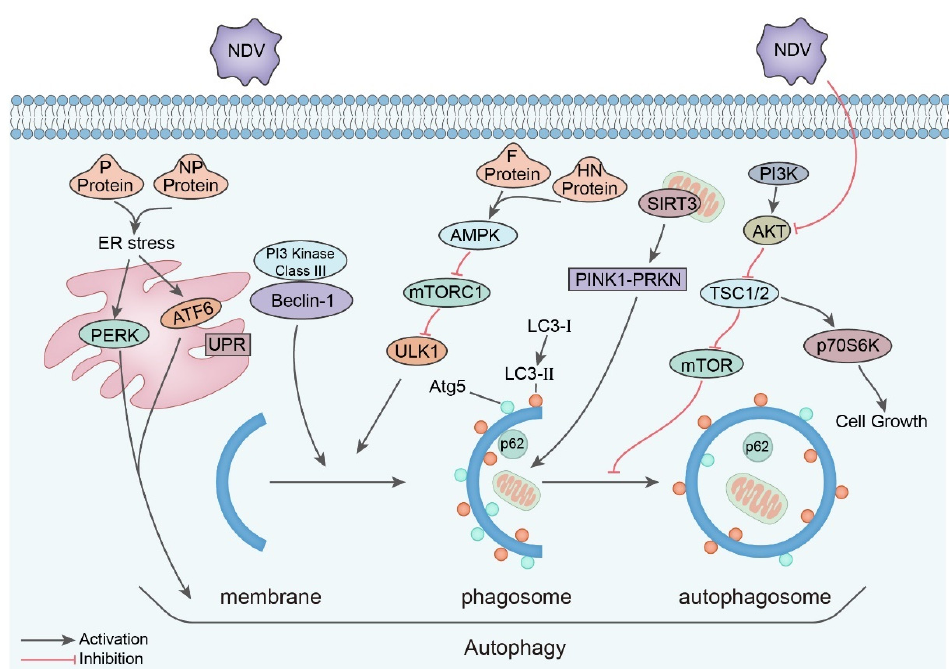
Figure 2. Autophagy in the pathogenesis of